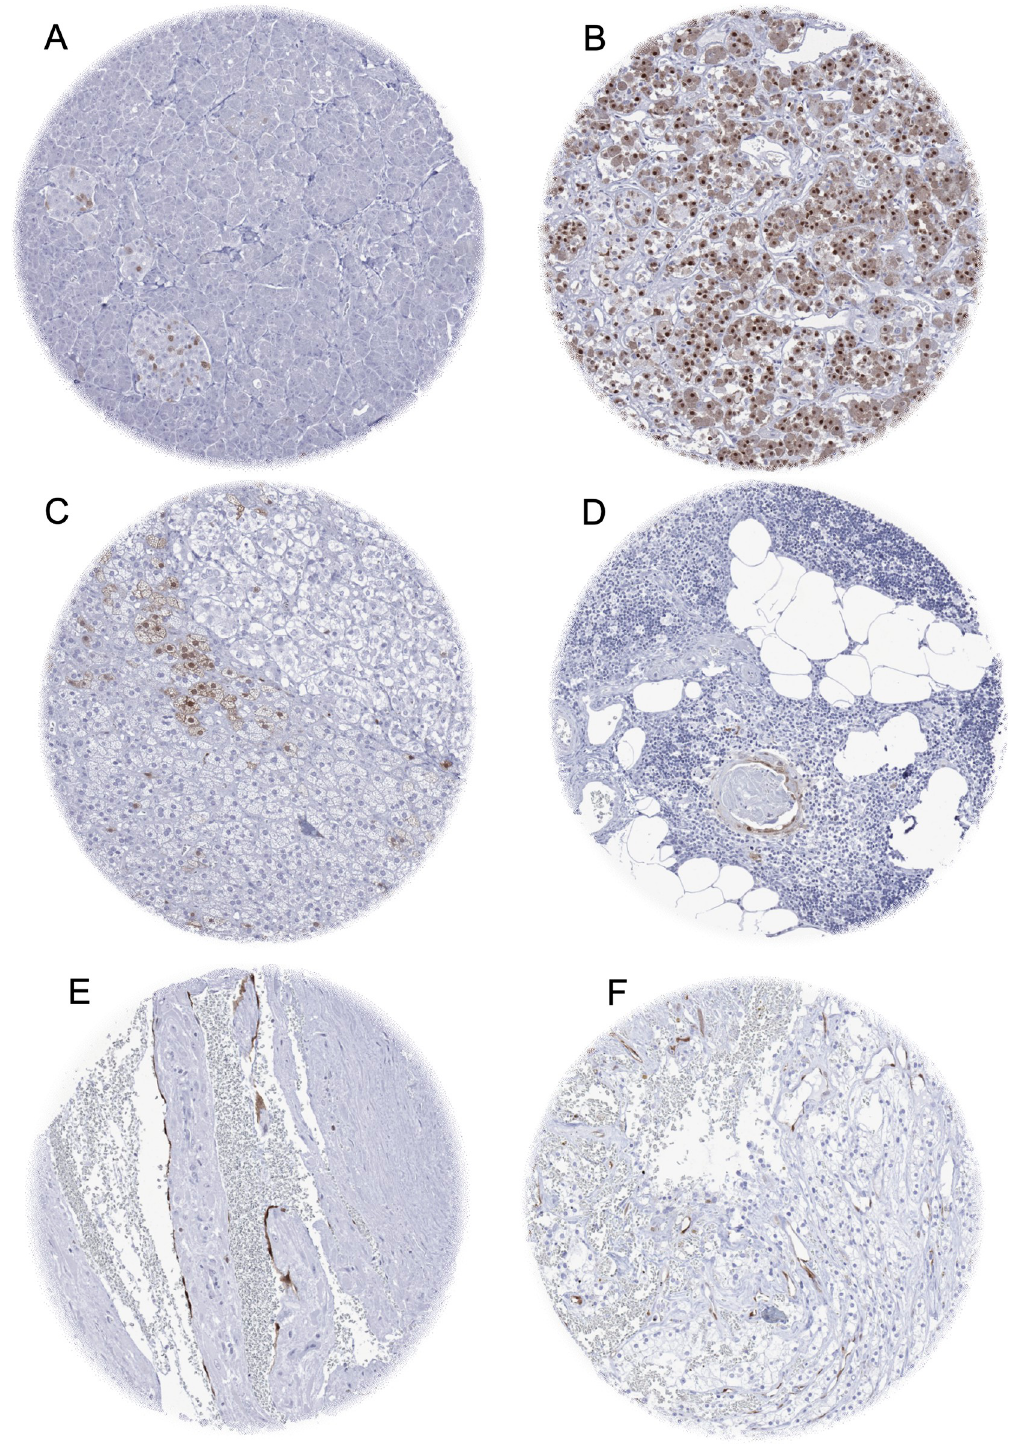
Fig 1. p16 immunostaining in non-neoplastic tissue. The panels show a nuclear and cytoplasmic p16 staining of a fraction of cells of pancreatic islets of Langerhans (A), a large fraction of epithelial cells in the adenohypophysis (B), a fraction of cells of corpuscles of Hassall‘s of thymus (C), and of scattered adrenocortical cells (D). A p16 positivity is also seen in endothelial cells of blood vessels in a normal placenta (E) and in an otherwise p16 negative clear cell carcinoma of the kidney (F).